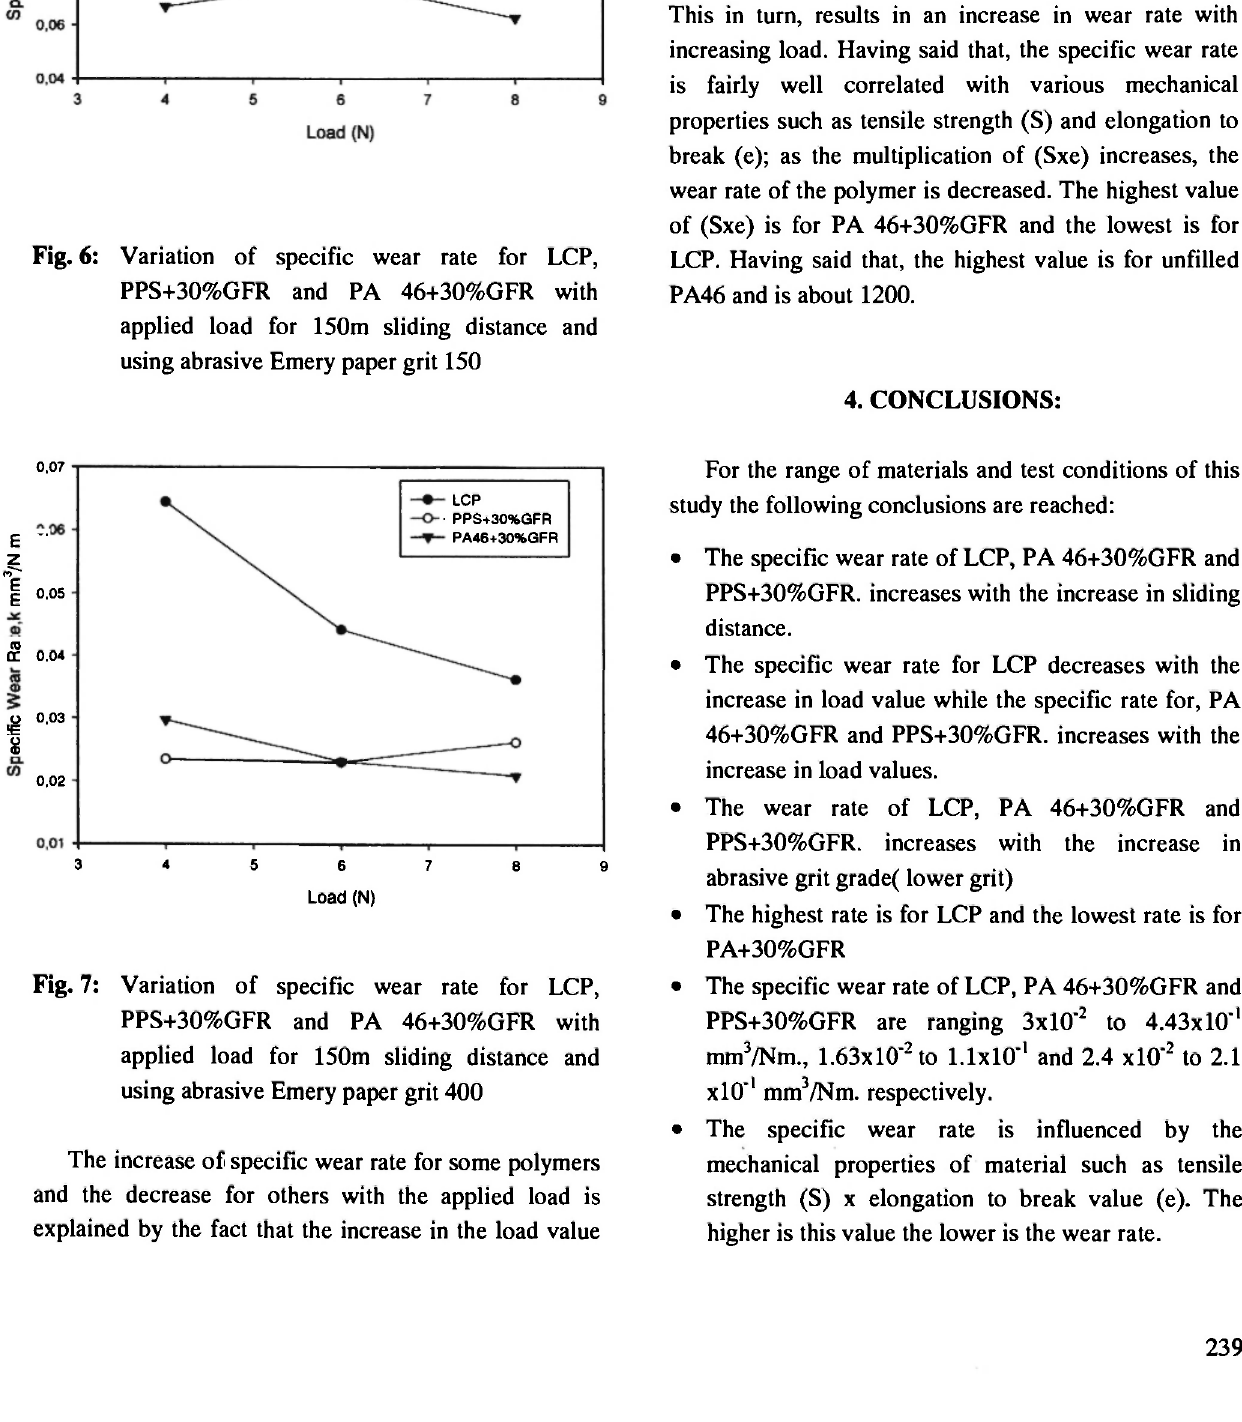
Fig. 6: Variation of specific wear rate for LCP, PPS+30%GFR and PA 46+30%GFR with applied load for 150m sliding distance and